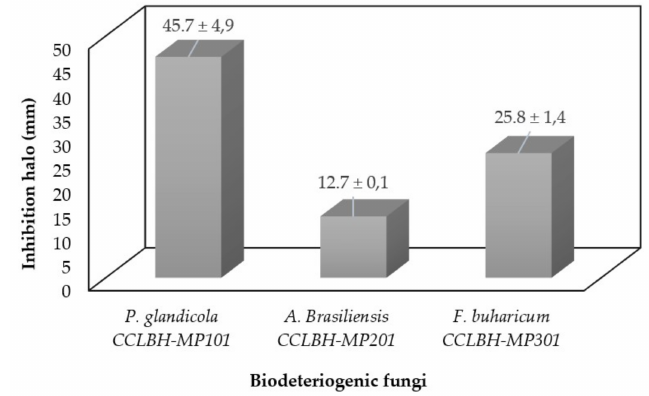
Figure 4. Antifungal activity of the bioactive compounds produced by Bacillus sp. CCLBH 1053 against P. glandicola CCLBH-MP101, A. brasiliensis CCLBH-MP201, and F. buharicum